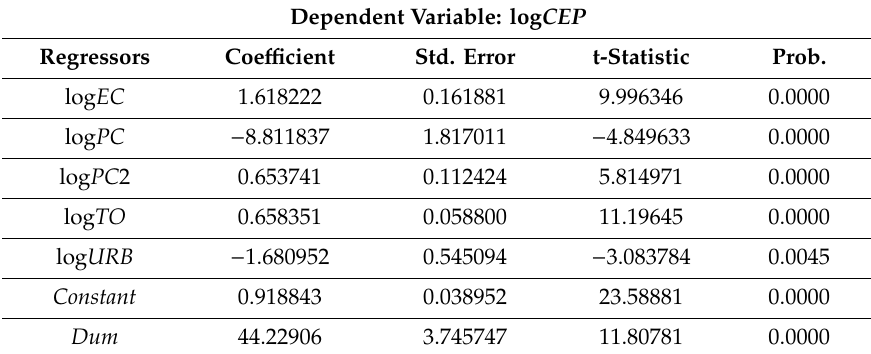
Table 3. Long term estimates.